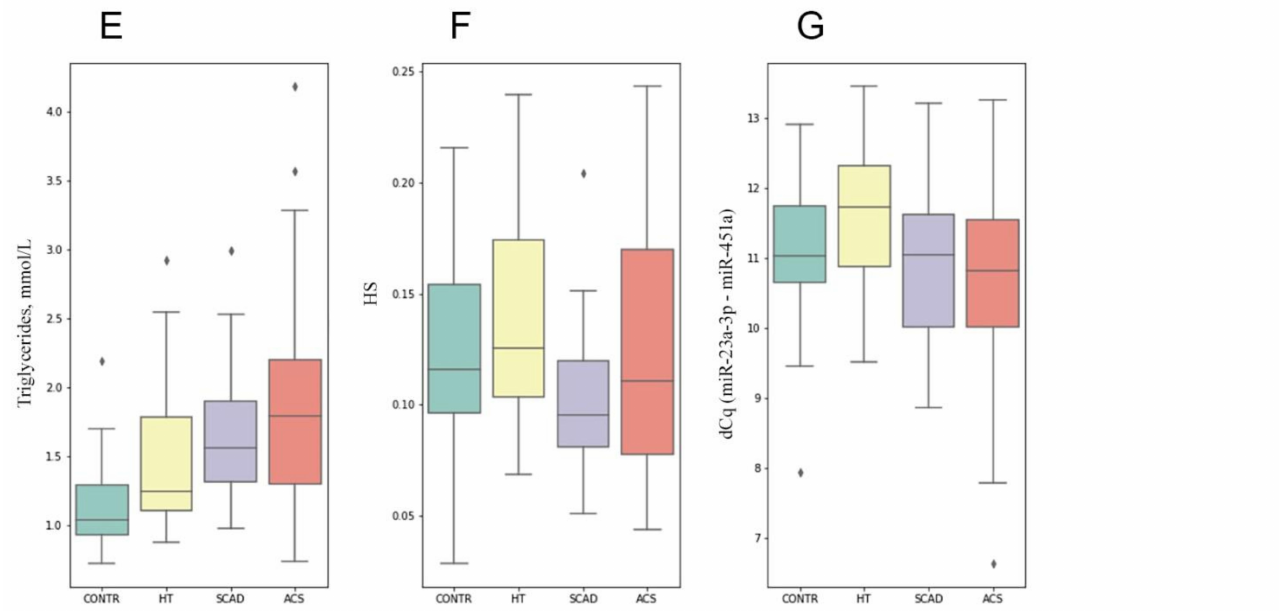
Figure A1. Distribution plots of the study sample characteristics—age ( A ), total cholesterol ( B ), LDL ( C ), HDL ( D ), triglycerides ( E ), HS ( F ), and dCq (miR-23a-3p–miR-451a) ( G )—in the study sample groups: ACS, 50 ACS patients; SCAD, 26 patients with stable CAD; HT, 30 hypertensive patients without CAD; CONTR, 30 healthy controls. The boxplots represent median and interquartile ranges (IQRs) in the box, minimum and maximum values in the “whiskers”, and outliers in the rhombic dots. LDL, low-density lipoproteins; HDL, high-density lipoproteins; HS, hemolysis score; dCq